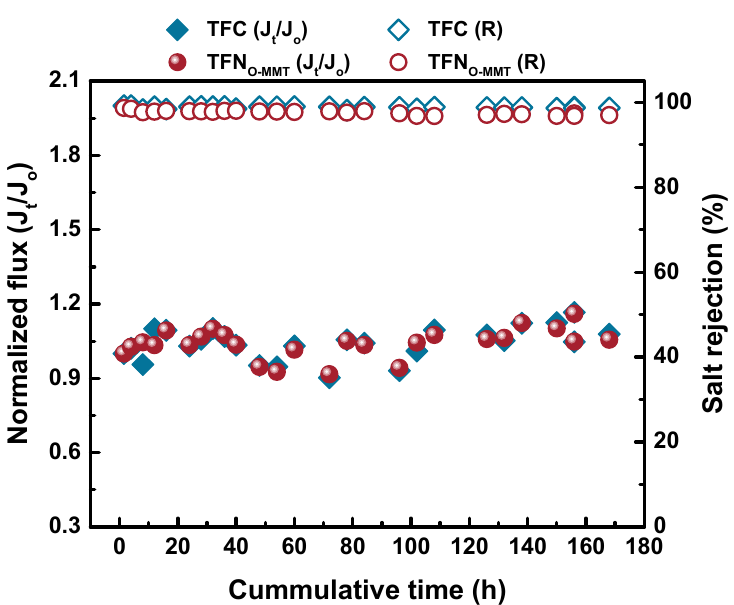
Figure 14. Stability test of TFC and TFN O-MMT membrane for 168-h. Feed = 1000 ppm Na2SO4 solution; Operating condition: pH = 7, 6 bar, 30 °C. The normalized flux was calculated as the ratio of flux (J t ) at time t over the initial flux (J o ) measurement.